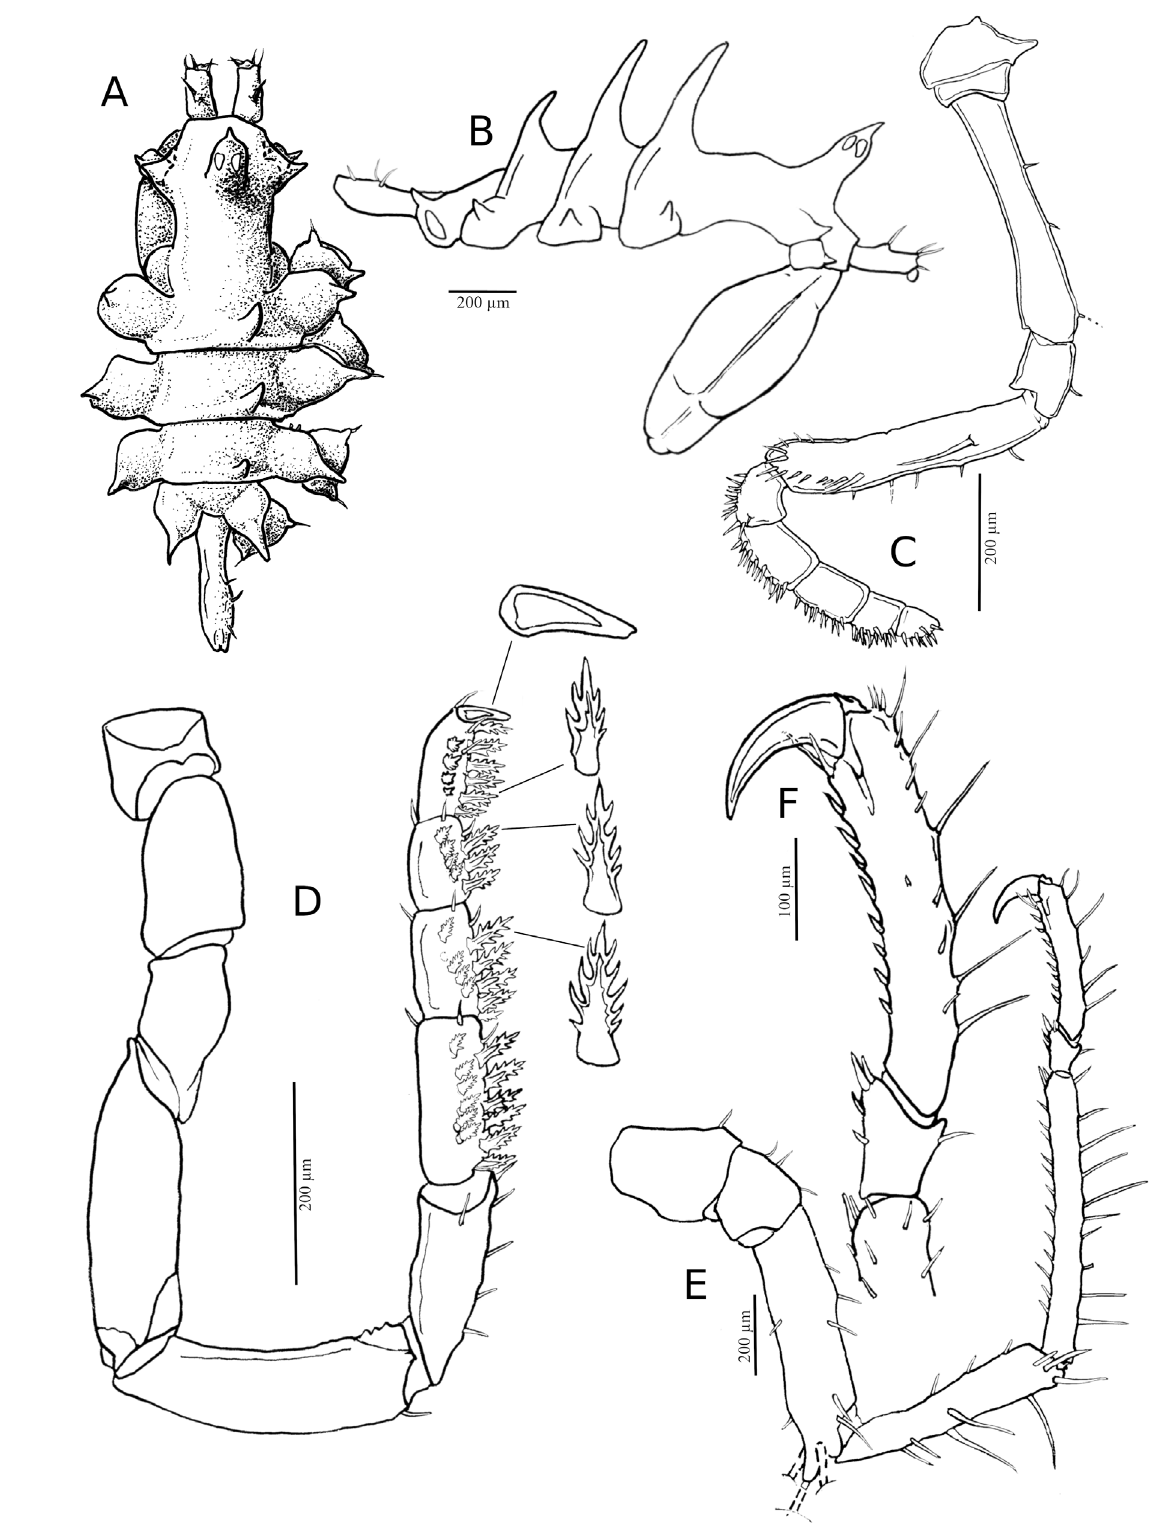
Fig. 7. Ascorhynchus iguanarum sp. nov., h olotype, ♂, MNHN-IU-2016-1047. A . Body, dorsal view. B . Body, lateral view (same scale as A). C . Palp. D . Oviger, with close-up of strigilis spines. E . Third leg. F . Tarsus and propodus of third